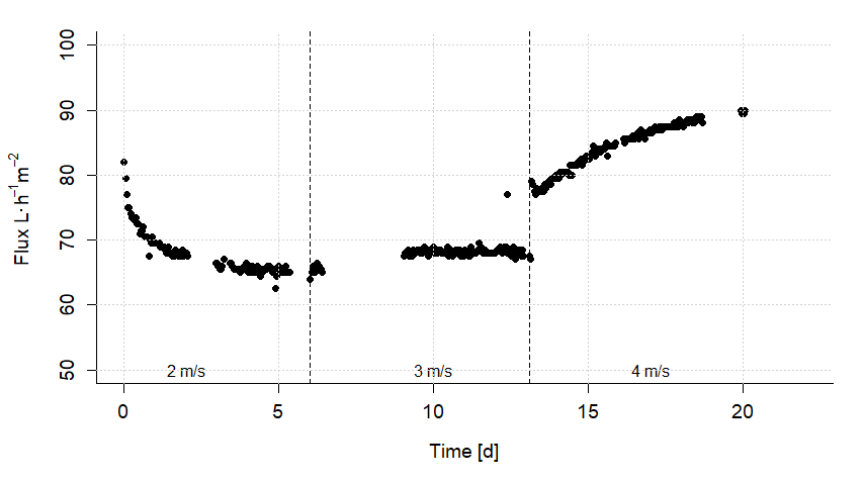
Figure 7. Long-term ultrafiltration experiment: Flux in dependence of the cross-flow velocity at a constant pressure of 1.5